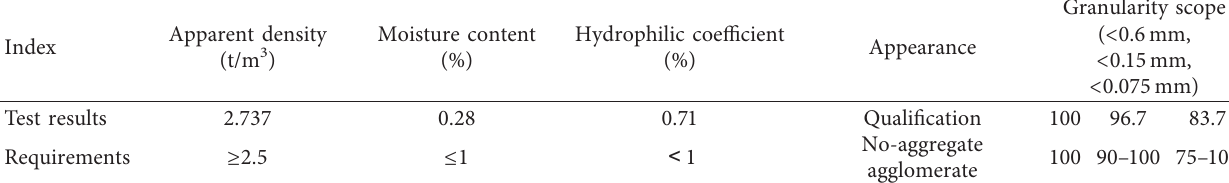
Table 6: Properties of mineral filler.